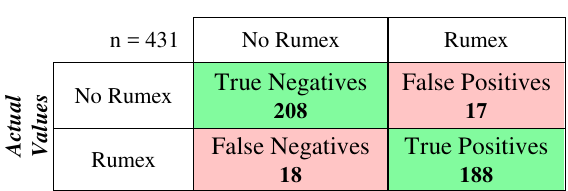
Figure 15. Confusion Matrix– Final model: Rumex moved and